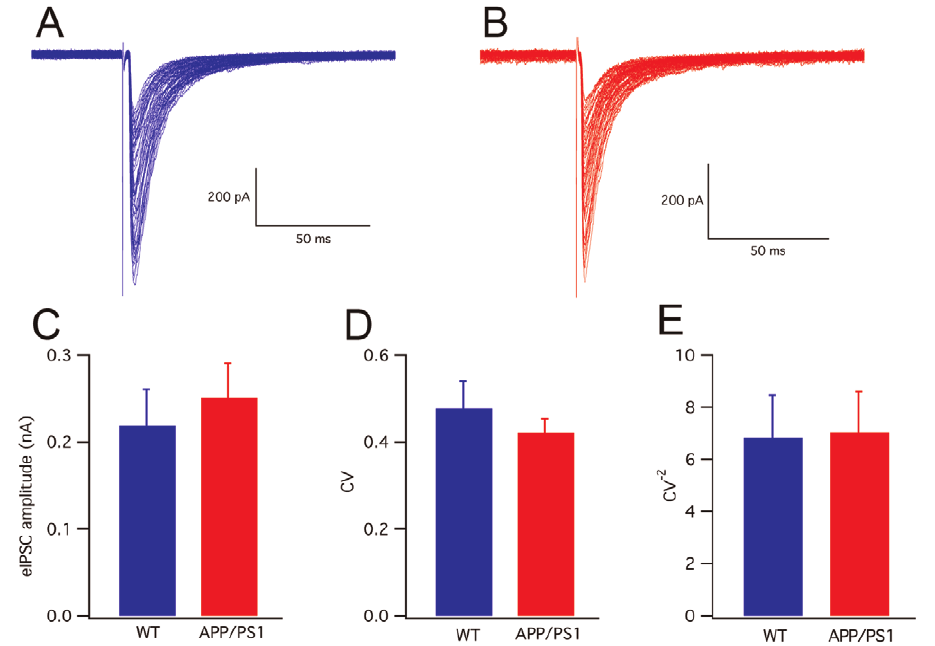
Figure 4. Evoked inhibitory post-synaptic currents (eIPSCs) in wild-type and APP/PS1 PCs. (A) Representative recordings of eIPSCs in wild-type and (B) APP/PS1 mice. The number of superimposed traces is 65 in A and 70 in B. There is no significant difference (number of cells n=10 for wild-type, n=11 for APP/PS1; P . 0.05) between the two groups in either the amplitude (C) or the coefficient of variation (D) or the CV 2 2 (E).